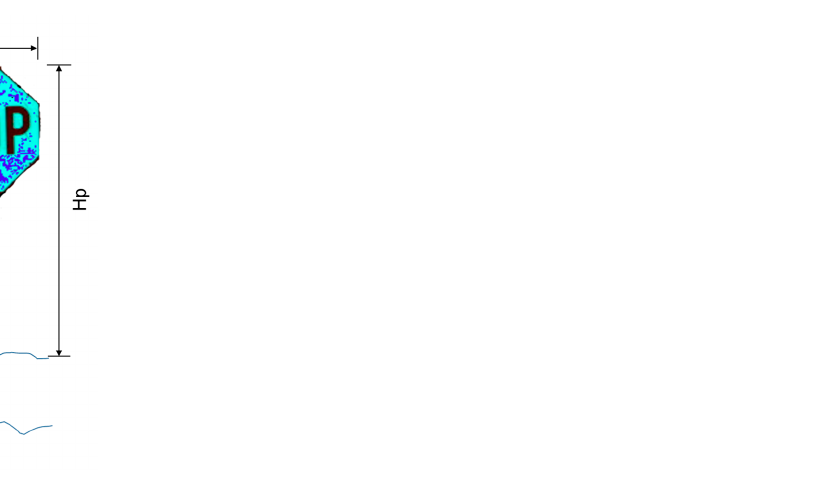
Figure 4. Parameters extracted from the first part of water level retrieval using masked stop sign images in flood. Wp, sign width in pixel; Hp, unflooded sign height in pixel; Lp, unflooded pole length in pixel.